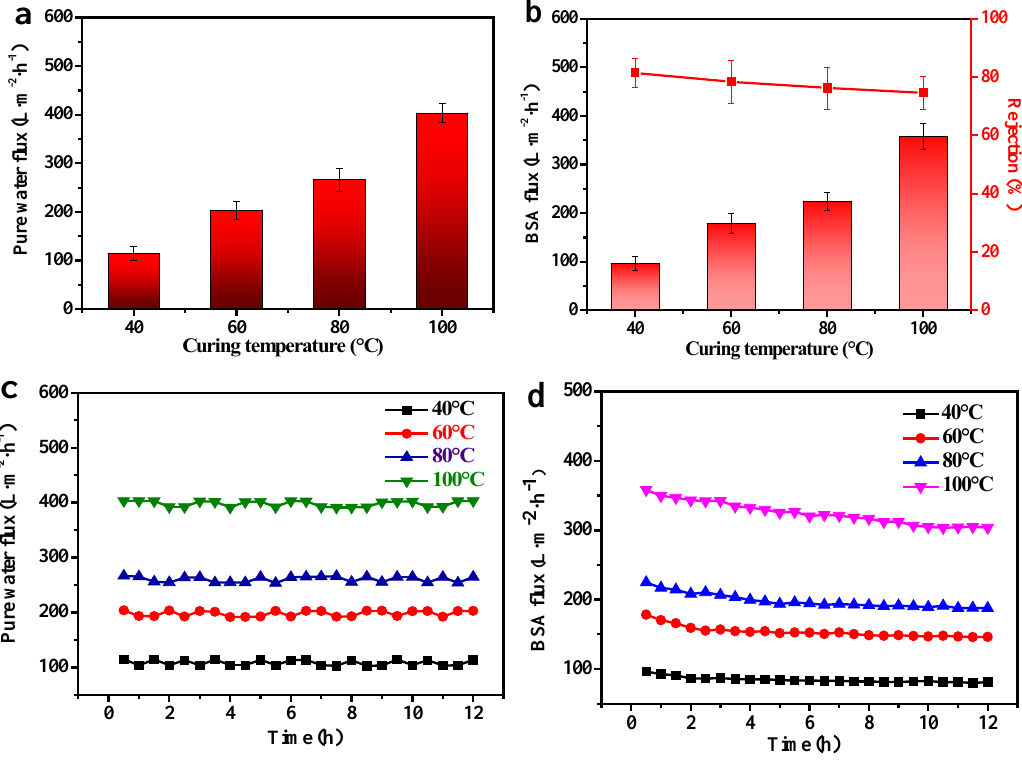
Figure 10. Permeability and separation performance of PSCMs based on the hot-dry casting at different temperatures: ( a ) the pure water flux of the PSCMs, ( b ) the BSA flux and rejection rate of BSA solution, ( c ) the pure water flux stability test of the PSCMs, and ( d ) the BSA flux stability test of the PSCMs.